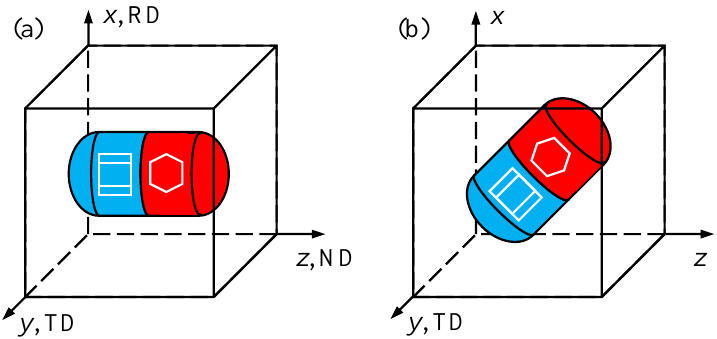
Figure 2. Morphology and initial orientation of the mesoscale microtexture regions (MTRs). ( a ) Compression along the normal direction ( z axis). ( b ) Compression along the diagonal direction ( x axis). For both cases, the red region is MTR 1 and the blue region is MTR